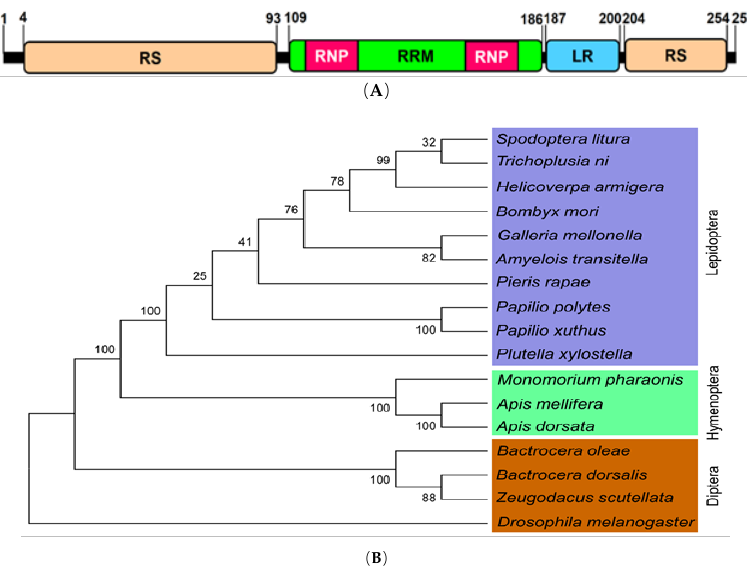
Figure 1. Molecular characters of Transformer-2 gene ( Zs-Tra2 ) of Zeugodacus scutellata . ( A ) Functional domains and motifs were predicted with Pfam (https://www.pfam.xfam.org/): Arginine/serine rich